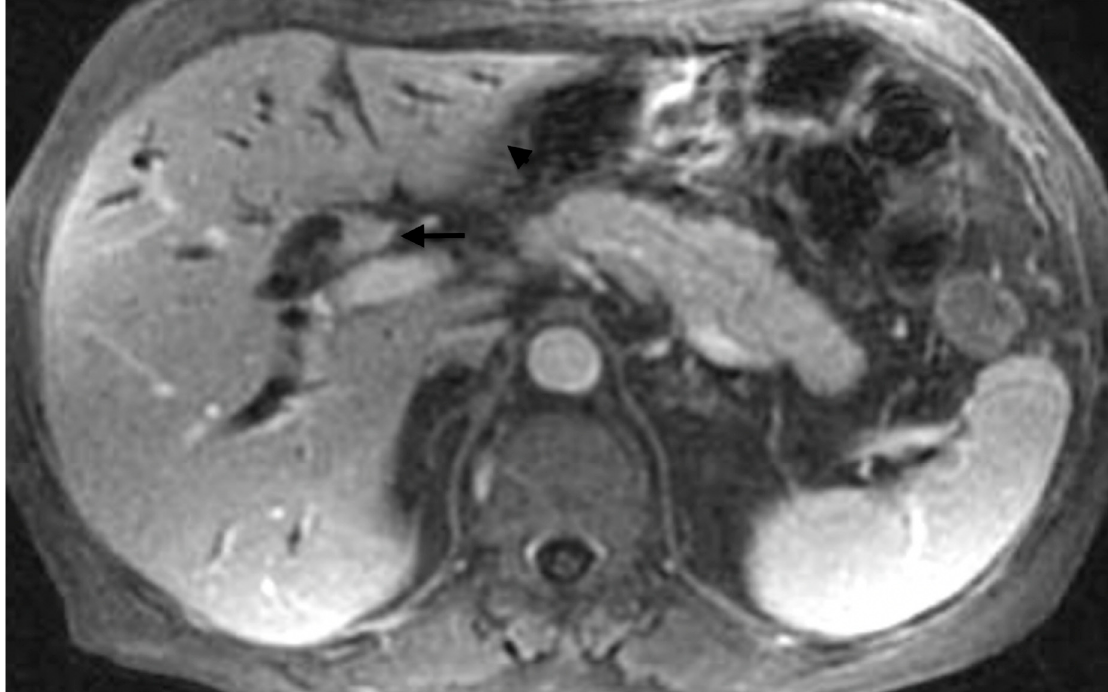
Figure 3. Abdominal MRI showing a hilar cholangiocarcinoma (arrow) with left liver lobe atrophy (arrowhead).